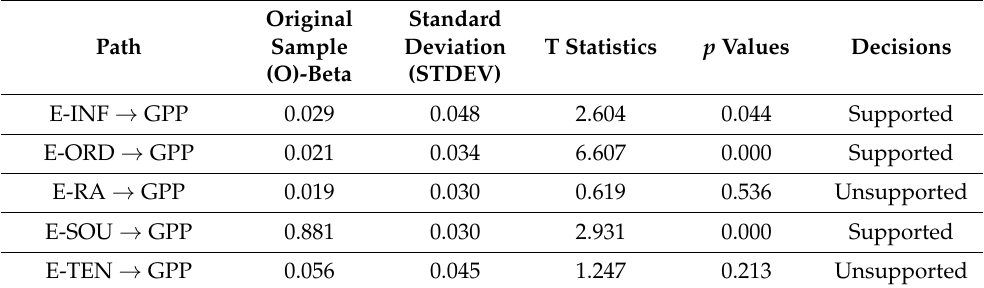
Table 9. Hypotheses